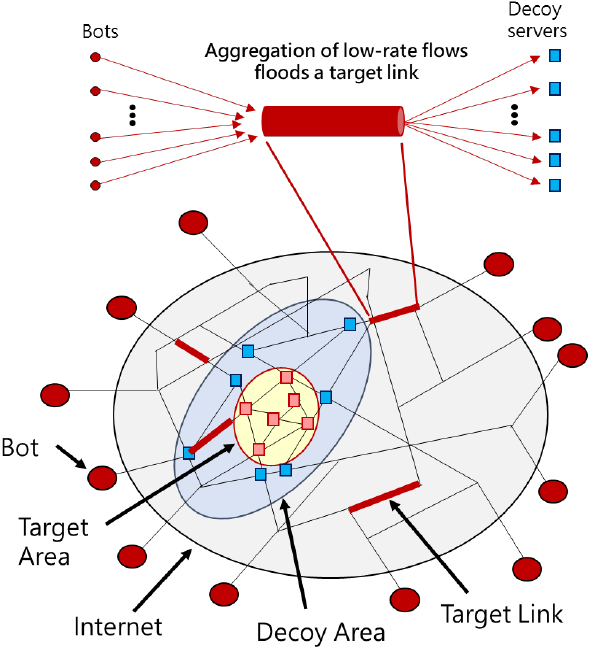
Figure 1. Link flooding attacks (LFA) situation.